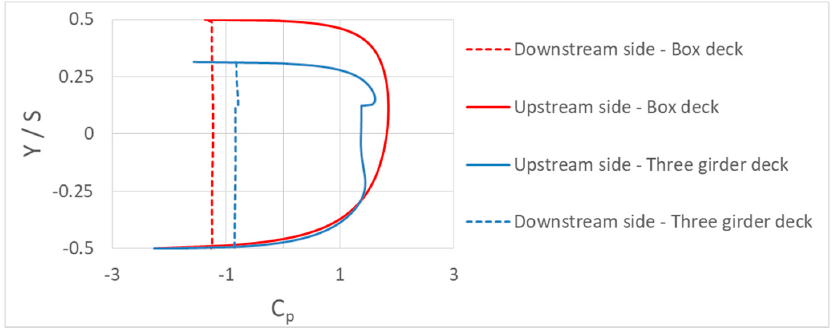
Figure 32. Comparison of the pressure coefficient between the box deck and three girder deck, Fr = 0.32, h* = 2.